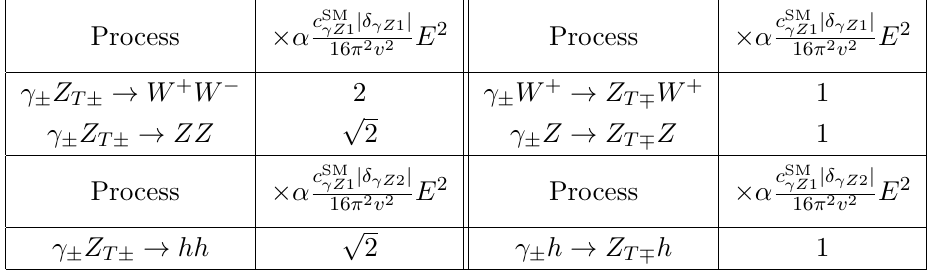
Table 5 . | ˆ M | of the 4-body model-independent unitarity-violating processes arising from the modification of the Higgs coupling to γZ .